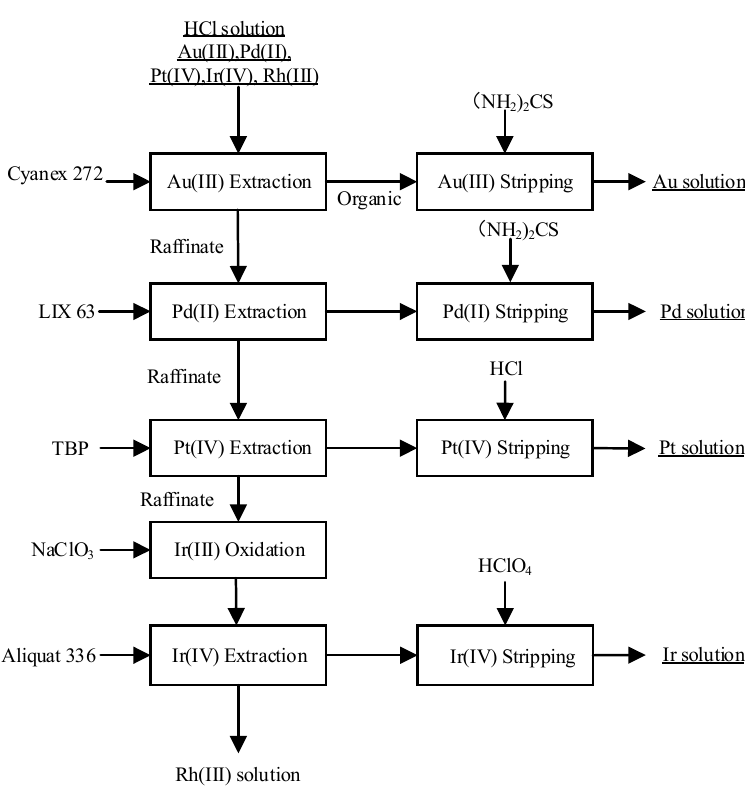
Figure 4. Integrated process for the separation of noble metals from a HCl solution by solvent extraction. Table 1. Mass balance of metals in each step of the process proposed in this work.